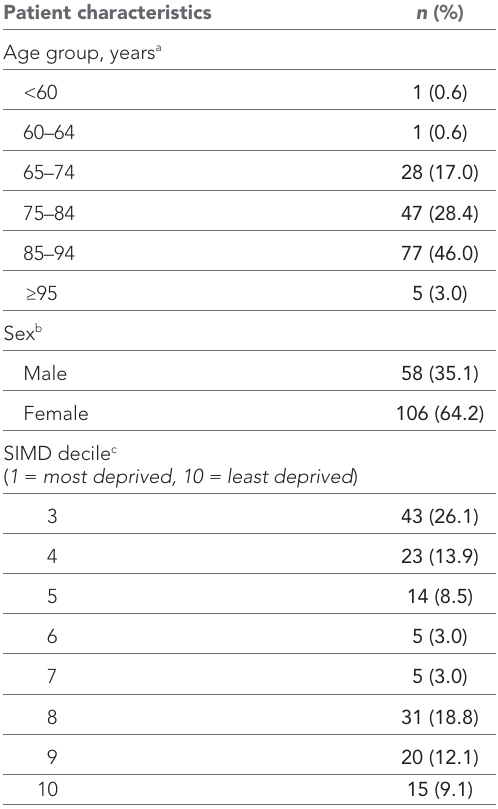
Table 1 Patient characteristics of responders who underwent a frailty assessment